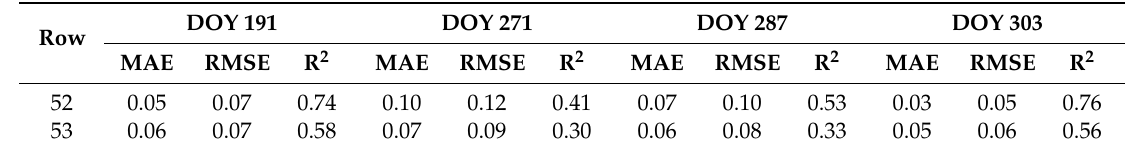
Table 2. Mean error values of the ESTARFM time series during the main rainy season validated with eight Landsat scenes of path 195 containing cloud cover of up to